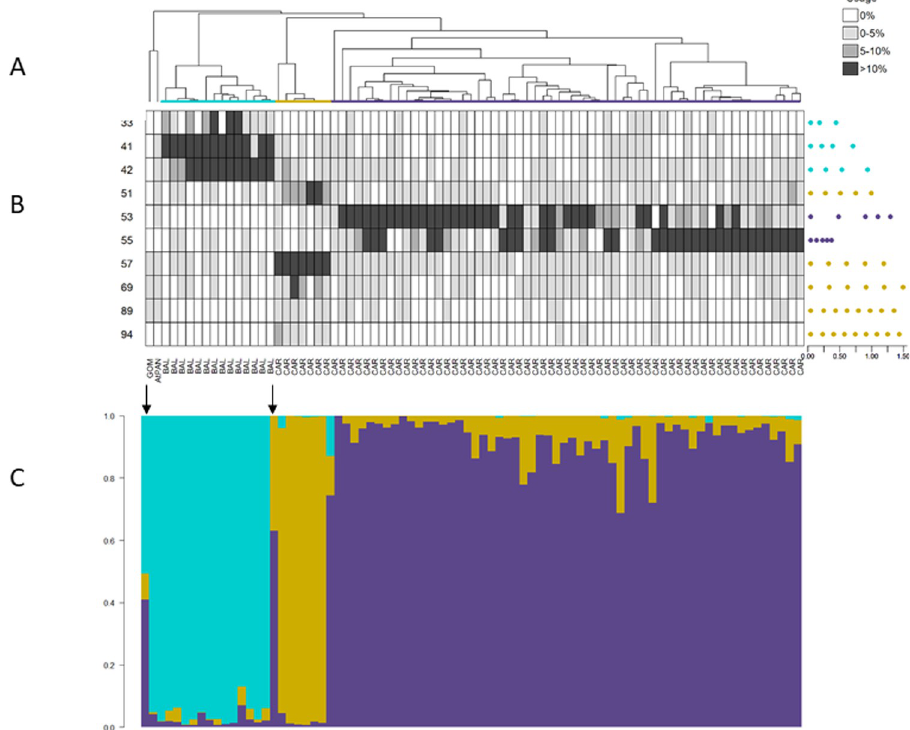
Fig 5. Identity clades, identity coda types, and posterior probabilities of repertoire assignment for Atlantic/ Mediterranean sperm whales. Output from IDcall (top; taken from [14]) depicts similarity among coda repertoires of sperm whale groups (data from [14]) recorded in the Atlantic Ocean and Mediterranean Sea. Colored identity clades correspond to three sperm whale clans: Mediterranean (cyan), EC2 (gold), and EC1 (purple). Location abbreviations are: AtPAN = Atlantic coast of Panama, BAL = Balearic Islands, CAR = eastern Caribbean islands, and GOM = Gulf of Mexico. Each coda was represented as a vector of inter-click intervals. Each repertoire (i.e. branch in the dendrogram) contains all the codas recorded from a known social unit of whales in a year or, if the identity of the recorded whales was unknown, all the codas recorded on a single day. (A) The average linkage hierarchical clustering dendrogram thus depicts similarity among 82 sperm whale coda repertoires. (B) The heatmap shows identity coda type usage (rows) for each repertoire (columns) in shades of grey, with usage calculated based on probabilistic assignment of codas to types. Identity coda type codes are on the left of the heat map and centroid coda interval vector plots are on the right (with the spaces between the dots representing the inter-click intervals and the scale bar in seconds). (C) The output from IDcallPP shows the posterior assignment probabilities of each repertoire belonging to each identity clade (i.e. vocal clan) as a stacked bar plot. See [14] for additional details.